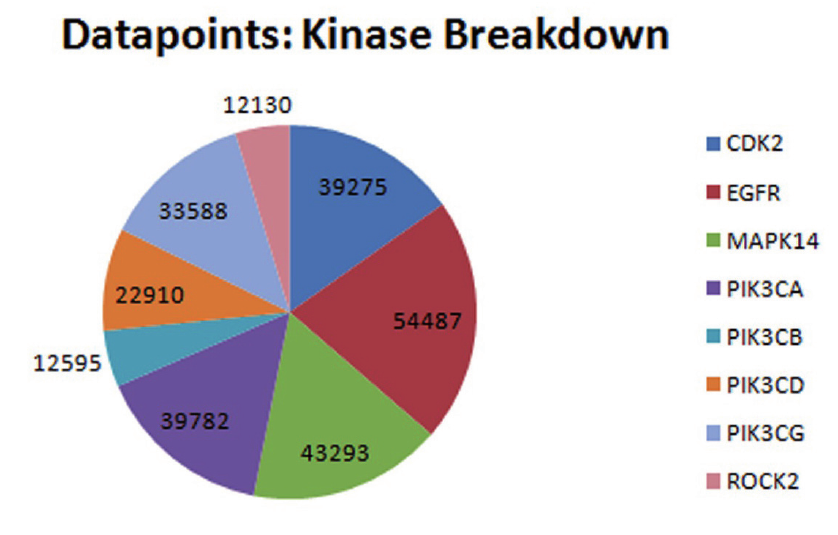
Figure 1. Data point distributions for each kinase.